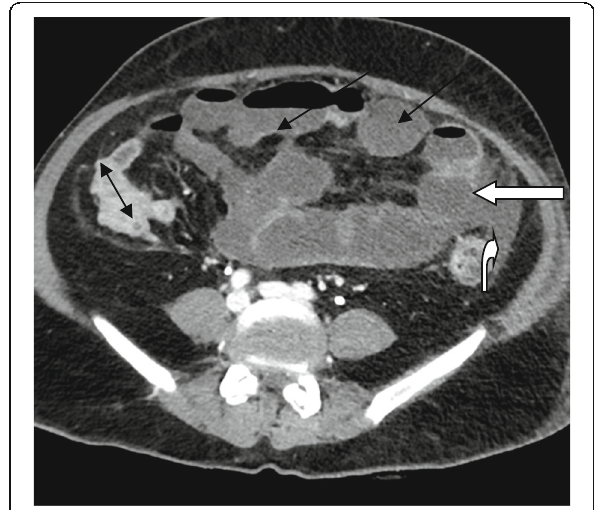
Fig. 4 Axial post-contrast CT abdomen done for ICU patient with abdominal distention with limited sonographic assessment with distended small bowel loops (long black arrows), collapsed large bowel loops (double-headed black arrow), there is small bowel segmental mural poor enhancement is noted (straight white open arrow) with related mild collection (curved white open